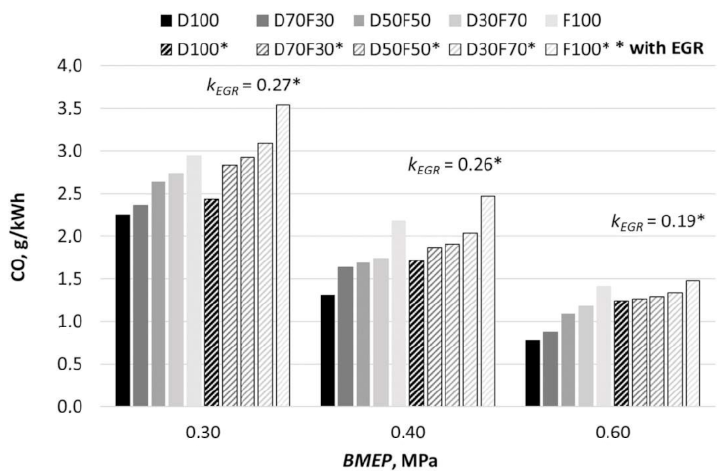
Figure 14. Dependence of CO emissions on fuel composition and engine load.